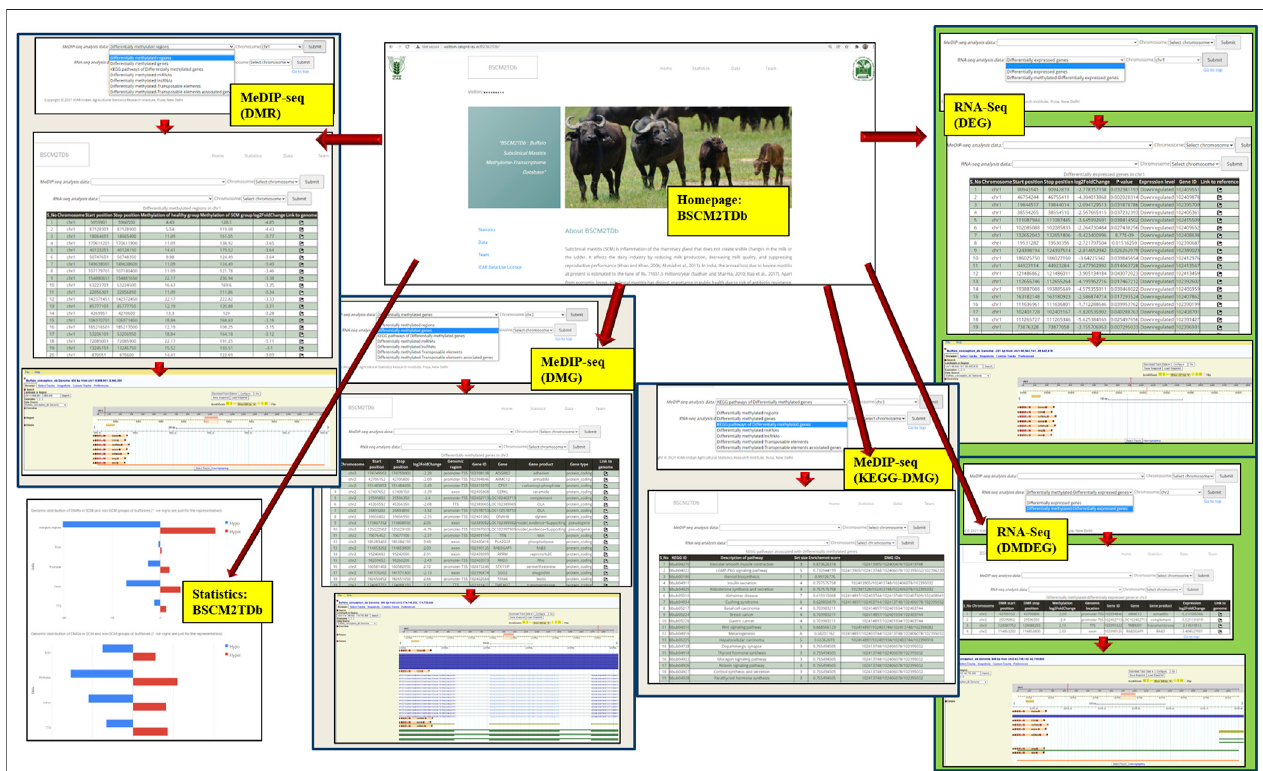
FIGURE 6 | Layout of the web resource